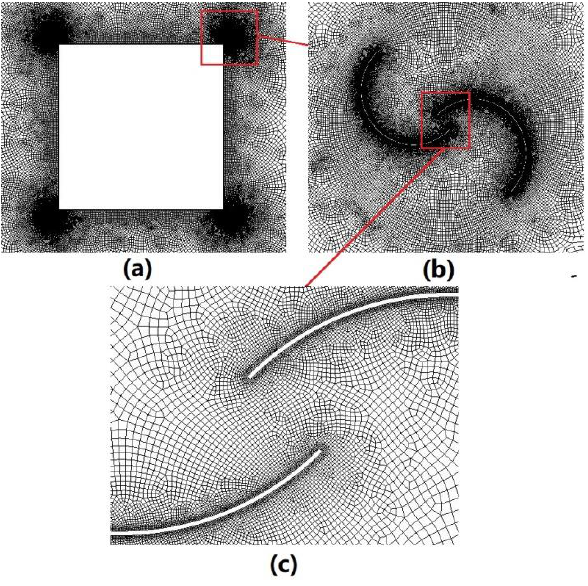
Figure 3. Computational domains and boundary conditions (the display is not scaled).